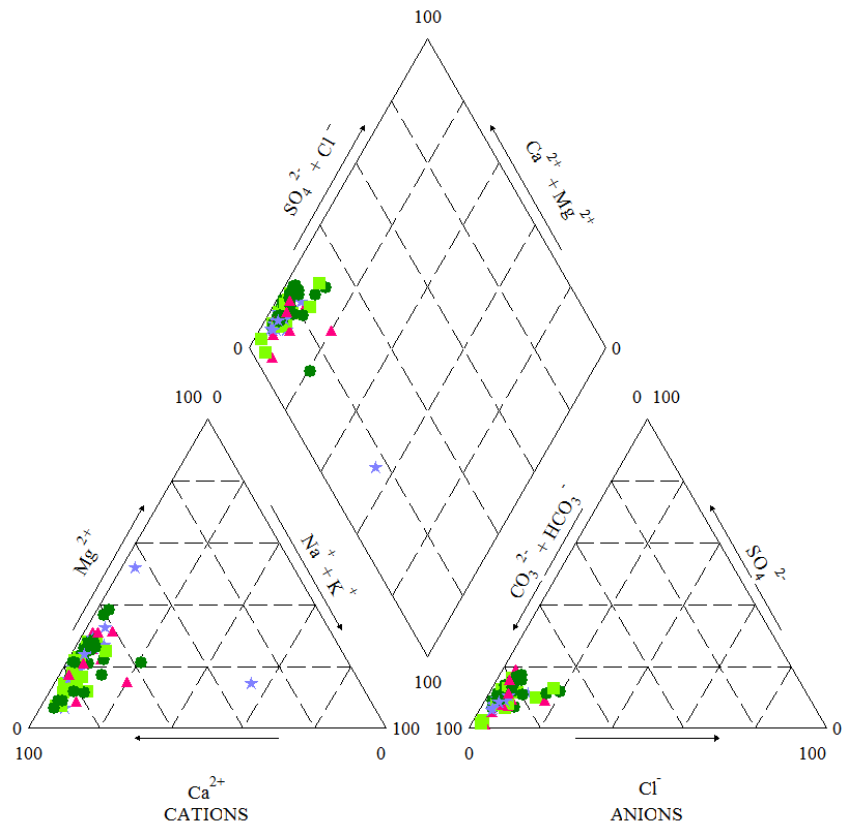
Figure 7. Hydrochemical types of water in springs in the Knyszyn Forest.